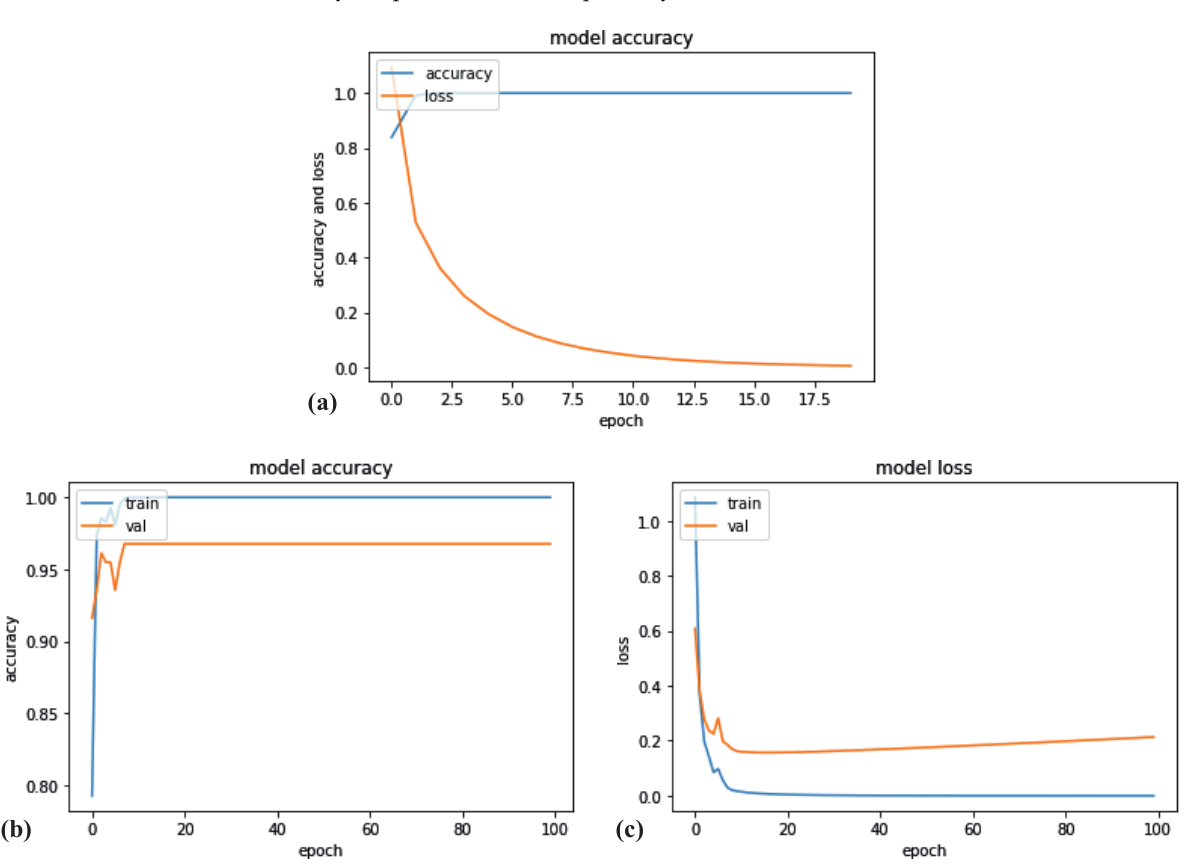
Figure 5. ( a ) Accuracy and loss plot for Case I and ( b ) Accuracy and ( c ) Loss for train and validation processes for Case II, δ frequency, Model 1, Adam